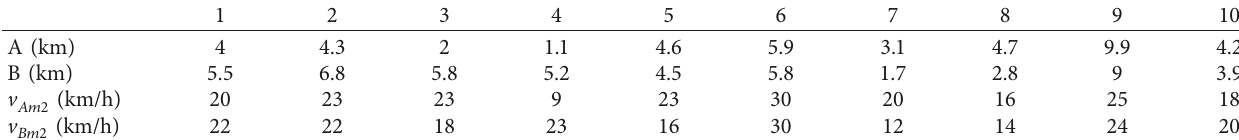
Table 4: Speed-distance matrix from distribution center to demand point.